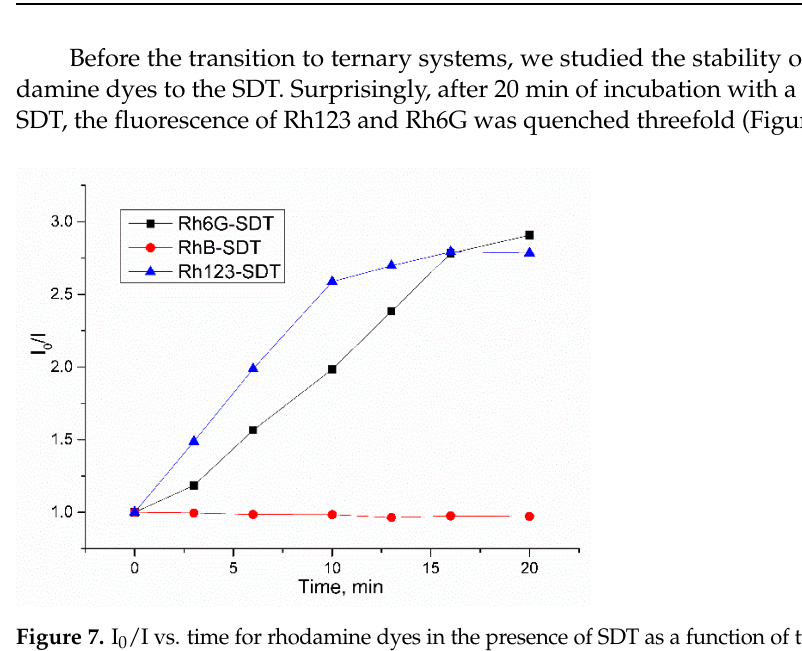
Figure 7. I 0 /I vs. time for rhodamine dyes in the presence of SDT as a function of time. C (dye) = 1 µ M, C (SDT) = 100 µ M, PBS buffer (pH